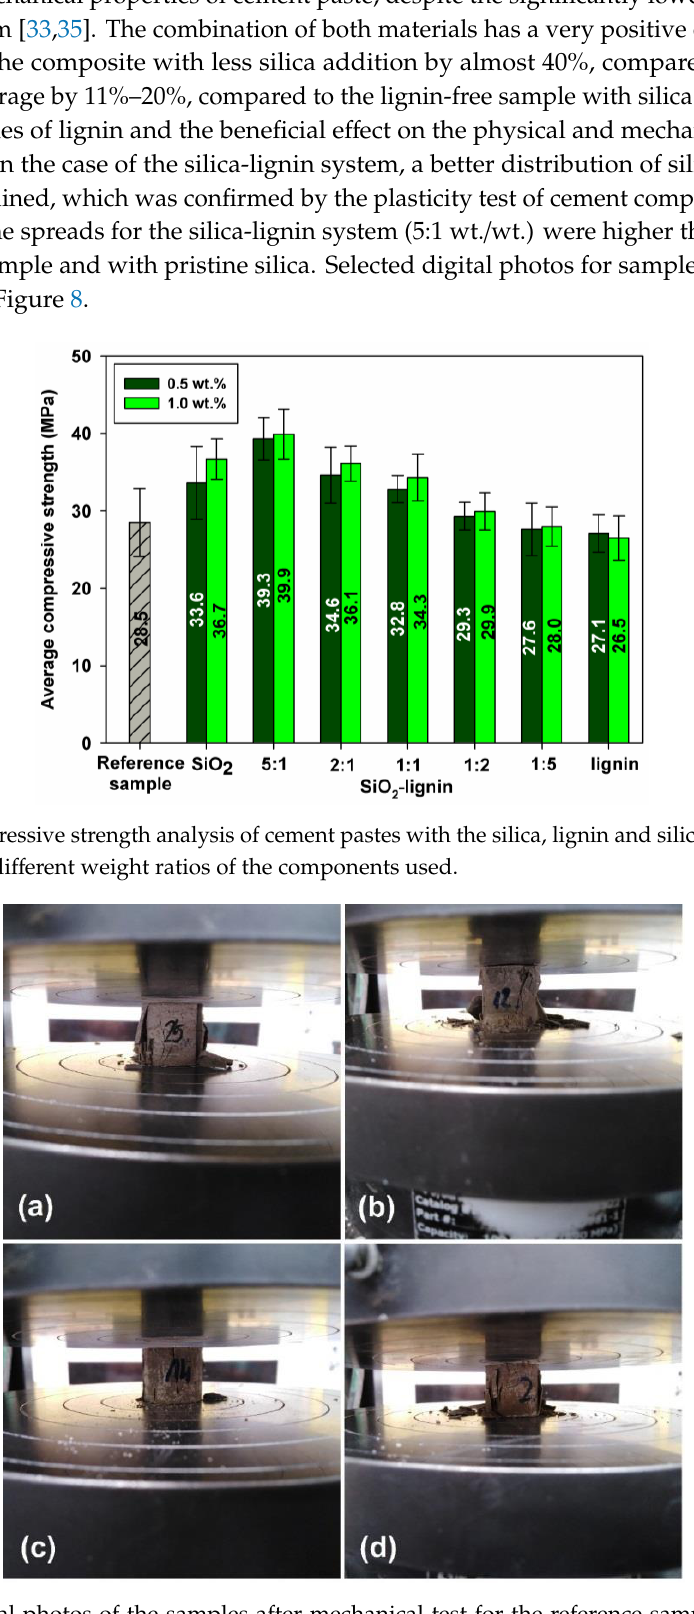
Figure 8. Digital photos of the samples after mechanical test for the reference sample ( a ) and the mixture containing 1 wt.% admixture of SiO 2 ( b ), SiO 2 -lignin hybrid 1:5 wt./wt. ( c ) and lignin ( d ).